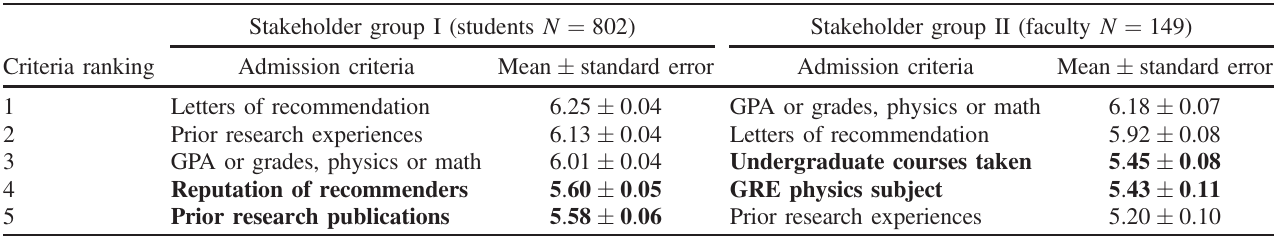
TABLE I. Mean response and standard errors for the top 5 high rated admission criteria. Bolded criteria are unique to each stakeholder group.